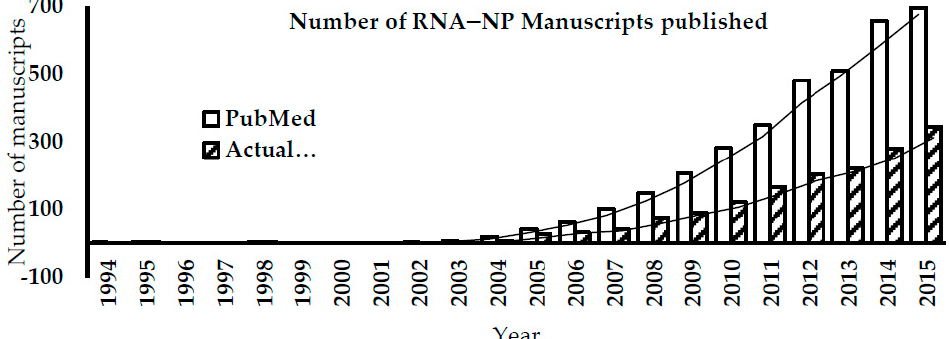
Figure 1. Literature search on the number of RNA-NP manuscripts published (on PubMed) using the keyword “RNA Nanoparticle” (or “RNA-NP”, “RNA-Nanoparticle” variations). The number of actual articles with RNA-NP content is substantially lower than the number from the general published (of RNA-NP) article search.